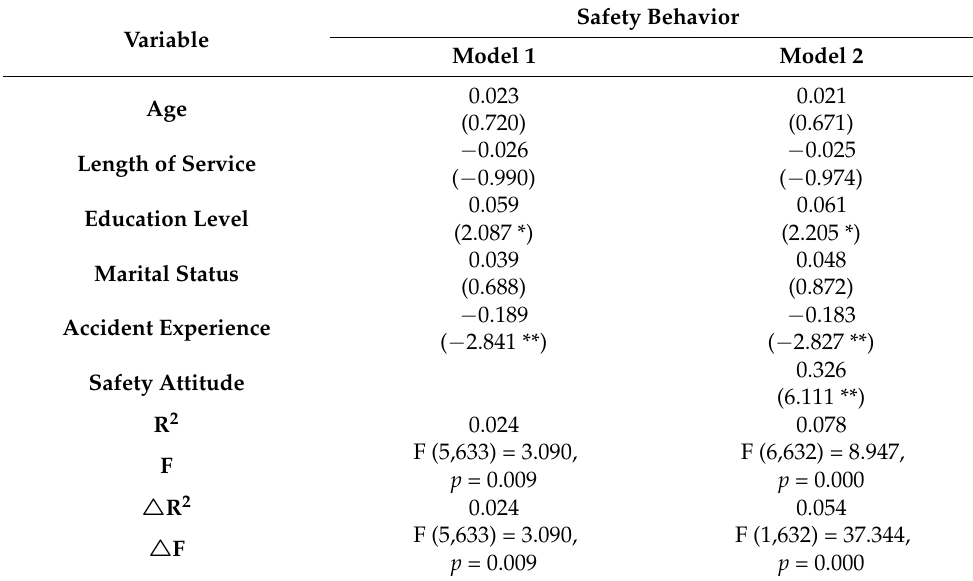
Table 14. Regression analysis of resilience on safety behavior (N =